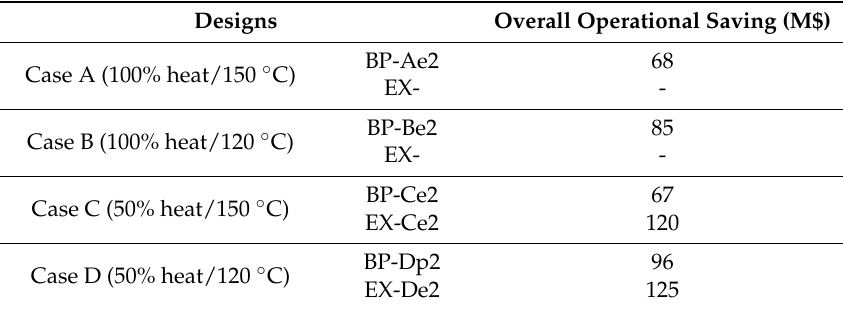
Table 10. Overall saving in operational costs associated with the utilization of offshore combined cycles instead of a simple GTs